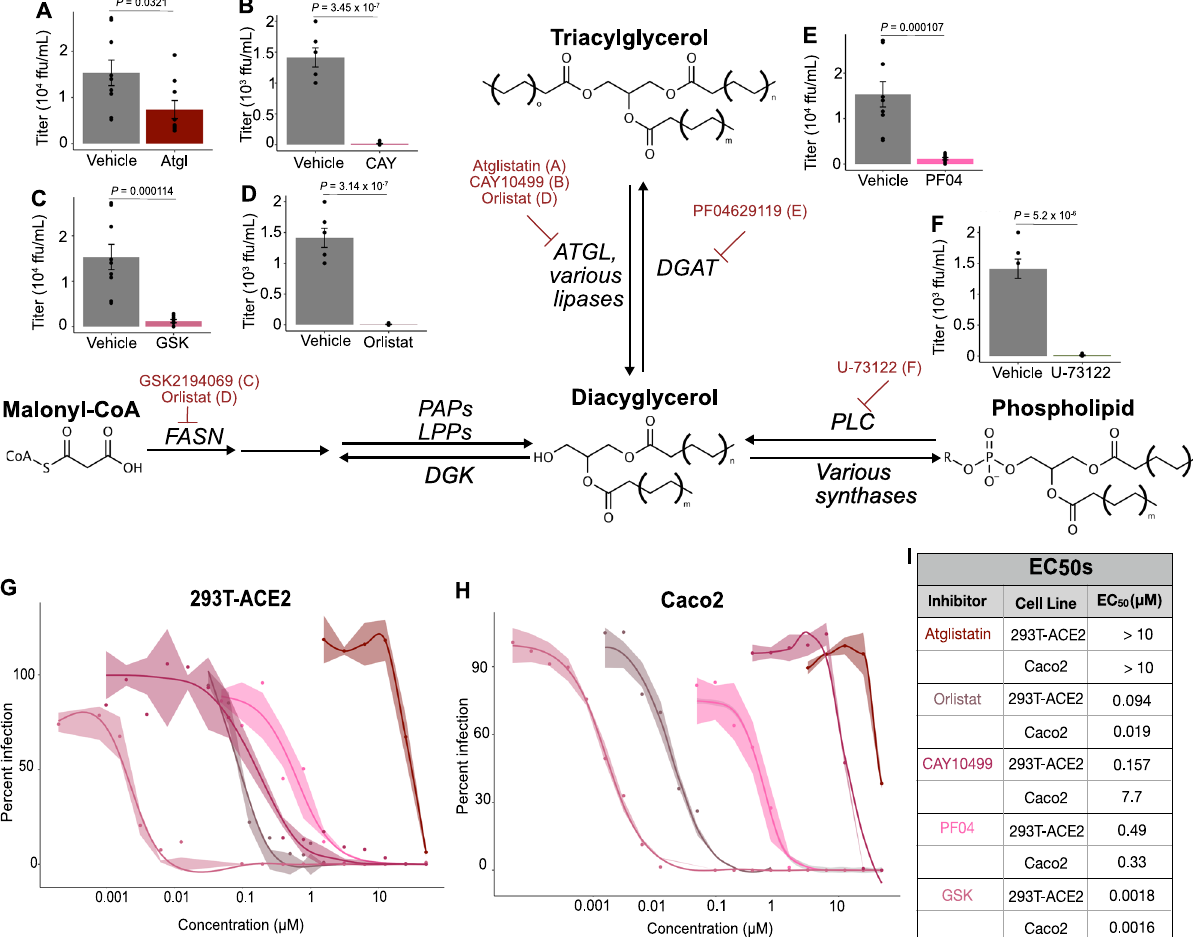
Fig. 5 Central glycerolipid metabolism is essential for SARS-CoV-2 infection. A – F Screen of neutral lipid biosynthesis inhibitors. HEK-293T-ACE2 cells were treated with 10 µ M of each compound overnight prior to infection. Cells were infected for 48 h prior to supernatant collection. Bars represent viral titers from cells treated with the indicated inhibitors, measured by focus-forming assay. The box plots are presented with the elements: center line, median; box limits, Q1 and Q3; whiskers, 1.5 x interquartile range, from three independent experiments; individual data points are also shown,